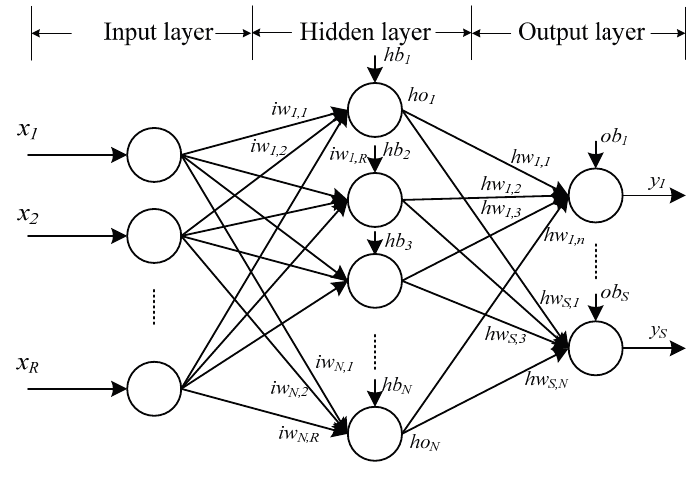
Figure 2. A feedforward network with one hidden